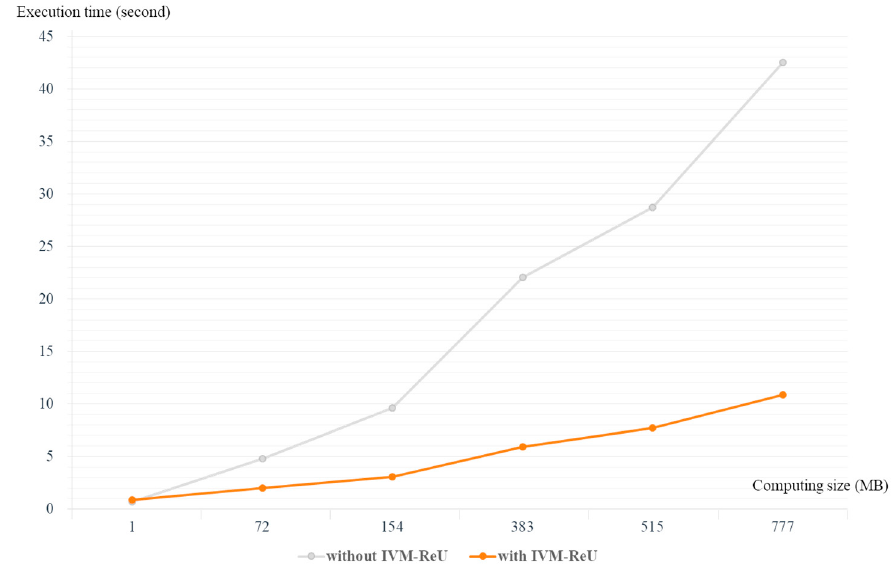
Figure 11. Comparison of execution time as the computing size increases.